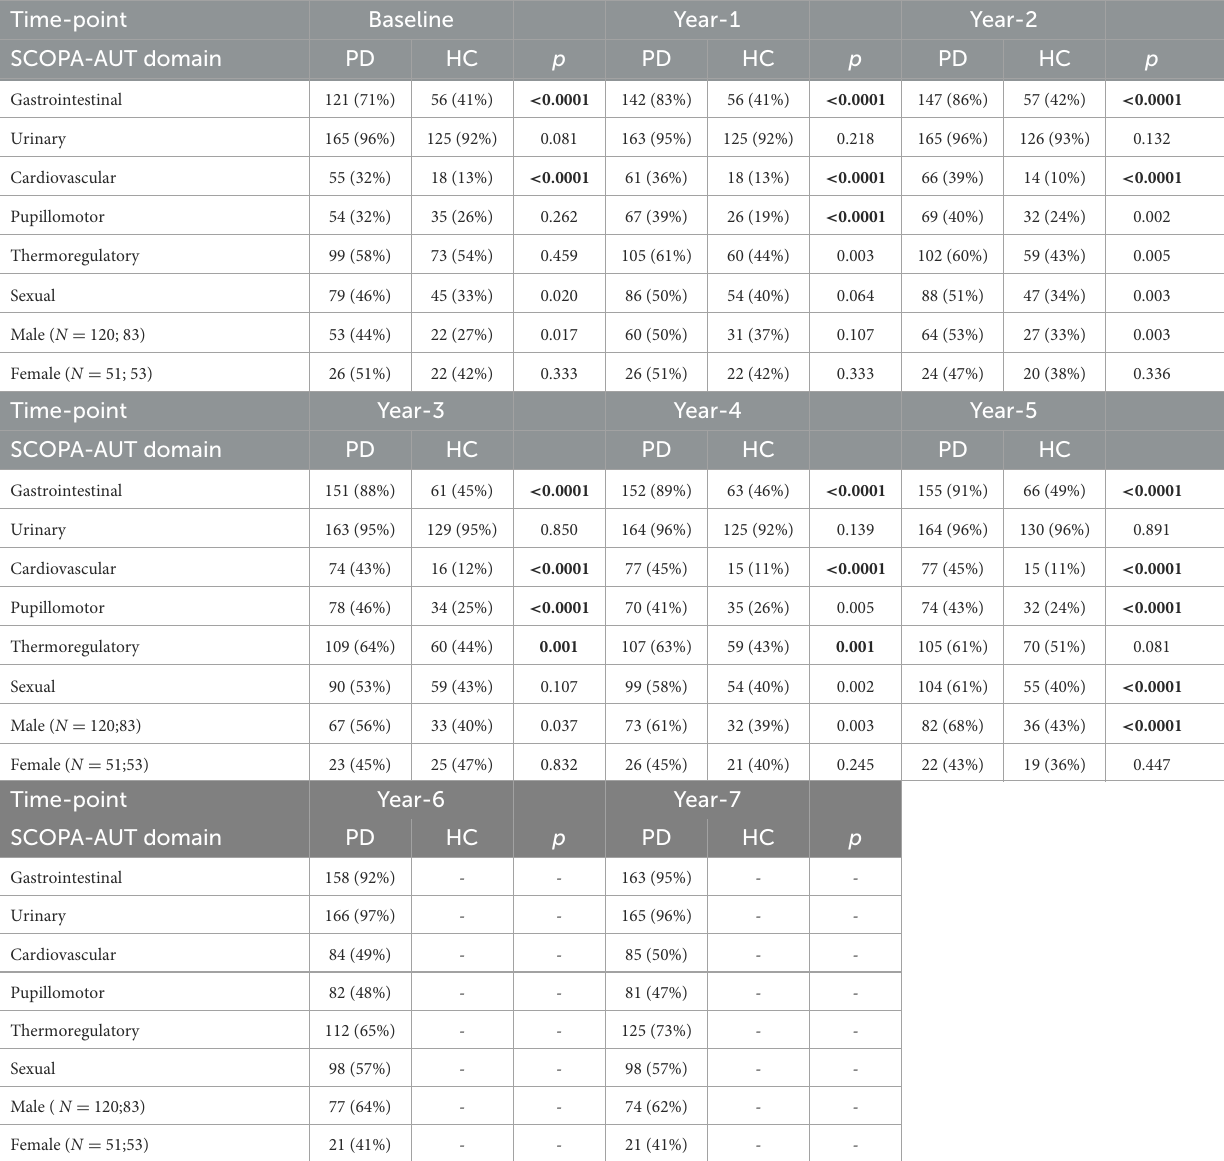
TABLE 2 Symptom frequencies from baseline to year 5 in HC, and to year 7 in PD. Number and percentage of subjects reporting symptoms in each domain